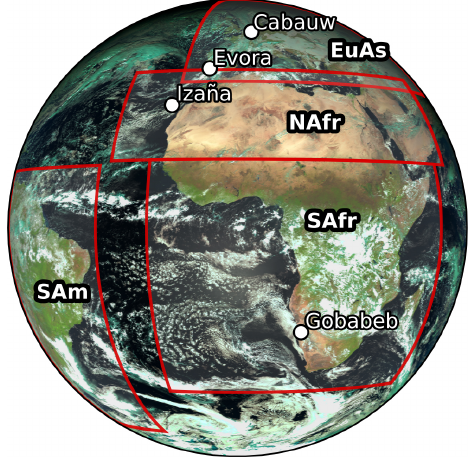
Figure 1. False color MSG SEVIRI image showing the region of primary coverage (“full disk”). Red boxes outline the sub-regions used for analysis (EuAs: Eurasia; NAfr: northern Africa; SAfr: sub- Saharan Africa; SAm: South America); white circles indicate loca- tions of in situ stations. Image from 19 December